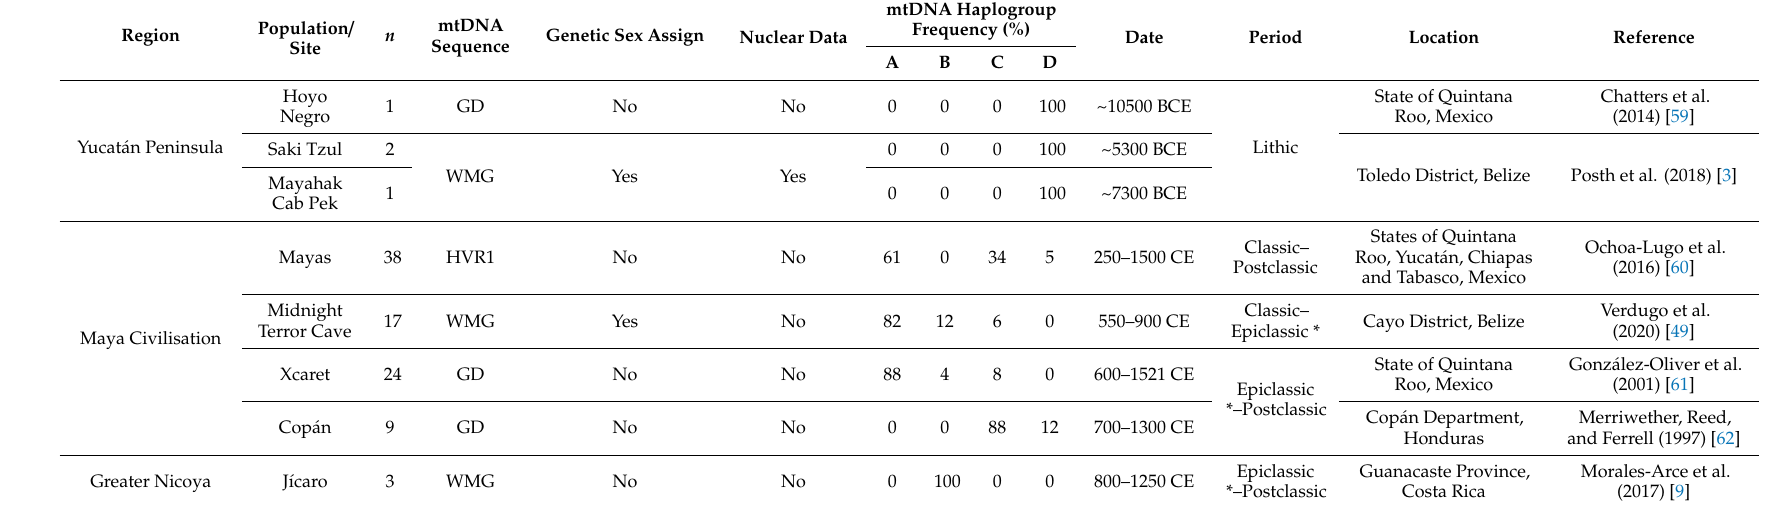
Table 3. Ancient DNA studies in the Yucat á n Peninsula, Maya Civilisation, and Greater